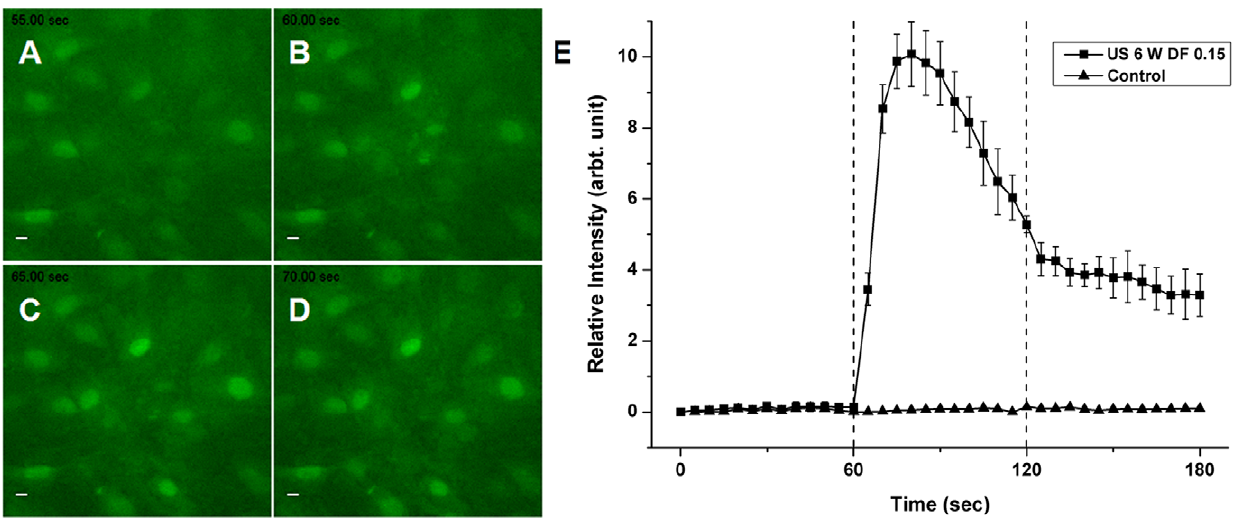
Figure 7. Changes in fluorescence intensities of MC3T3-E1 cells loaded with Calcium GreenTM-1. Time-lapse sequence images showing calcium influx in the cells before pulsed ultrasound radiation (A), at the start (B) of radiation and during the radiation (C and D). Compared to cells without ultrasound radiation, the pulsed ultrasound evoked a significant increase in intracellular calcium levels (E). Dotted lines represent duration of radiation on- and off-switch, respectively. Scale bar, 10 m m.